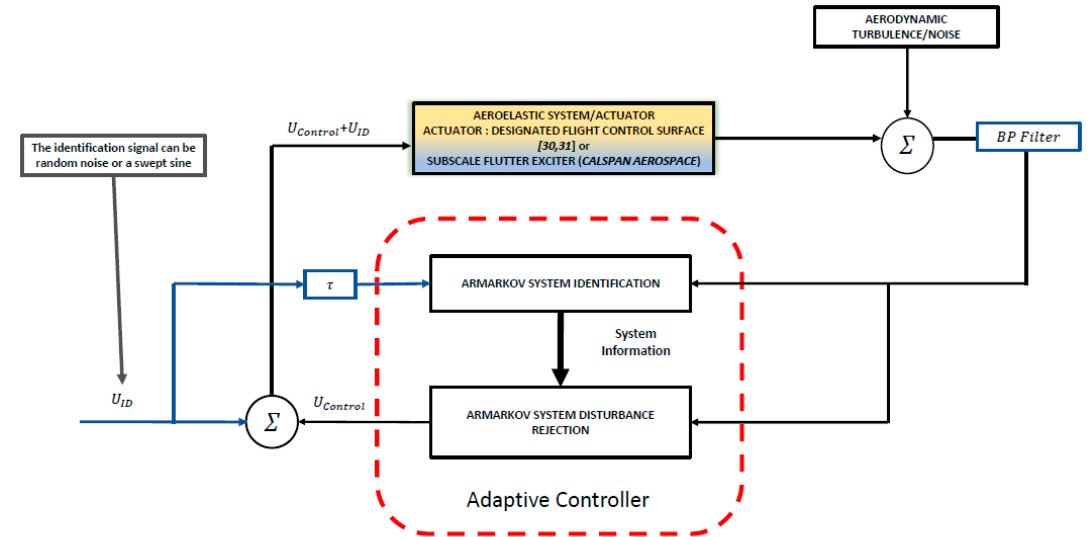
Figure 37. Schematic for adaptive system identification and disturbance rejection.